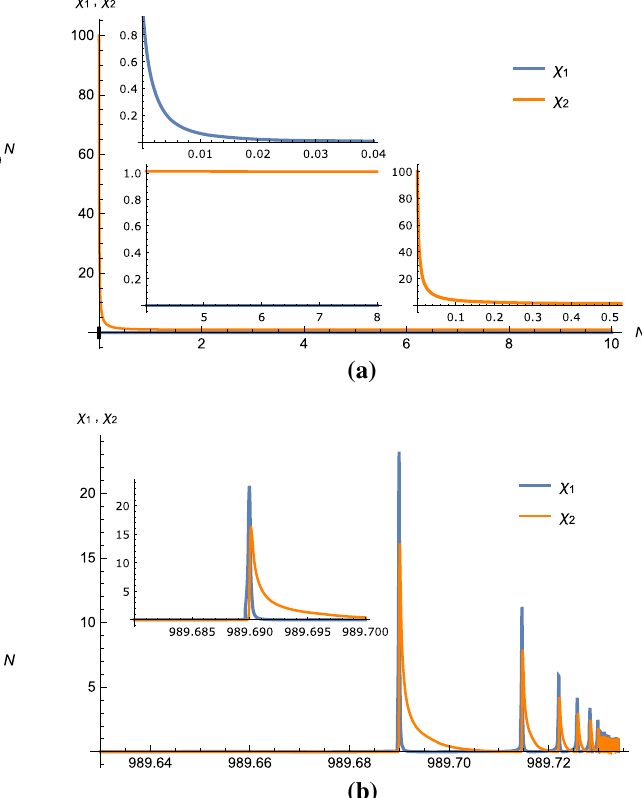
Fig. 7 Boththeaboveplotshavebeeninitiatedfrom χ 1 = 1, χ 2 = 100 with ξ = 400, M p =1 and λ = 1. a The deeper in the phantom region the faster motion toward the de Sitter attractor. Both variables then demonstrate very slow motion near the point (χ 1 = 0 ,χ 2 = 1 ) . b Oscillatory behavior appears after approximately 1000 e-folds. Both the χ 1 and χ 2 oscillations tend to reach unit amplitude,